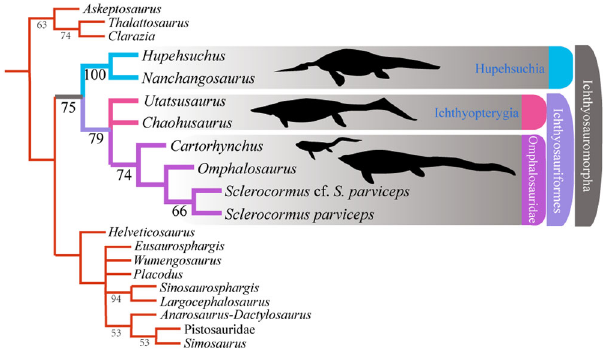
Fig. 9 Simpli fi ed version of the strict consensus of eight most parsimonious trees obtained from the matrix of 47 taxa and 220 characters. Bootstrap support values (>50%) are shown below the nodes.